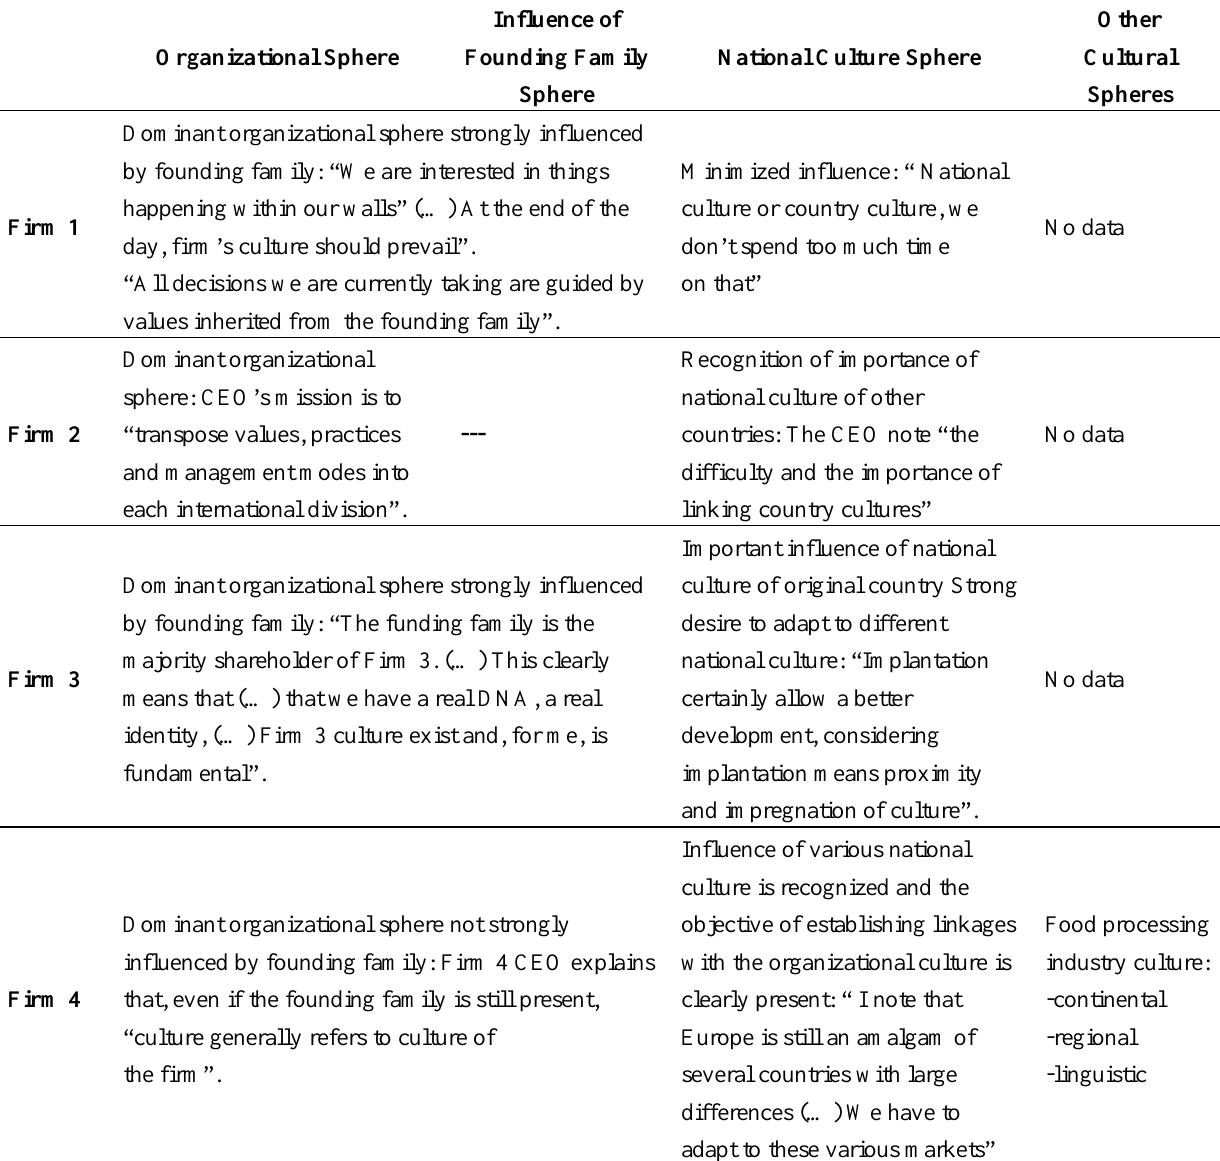
Table 5. Assessment and chosen examples of evidence of the influence of various cultural spheres on